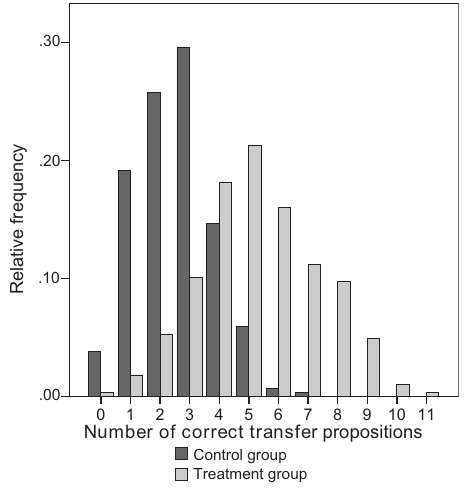
FIG. 8. Distribution of S transfer for control group and